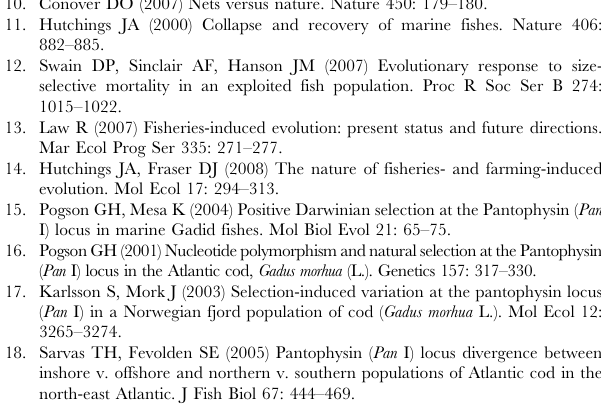
Figure S1 Generalized additive model smooth fit of frequency of A allele on depth of sampling. Shaded region represents two standard errors above and below fit; points are partial residuals; the gam smooth was fitted using a quasibinomial link function to model overdispersion; estimated degrees of freedom edf =3.2; approximate significance of smooth term F= 47.95 , P % 0.001 with 51.4% of deviance explained. Found at: doi:10.1371/journal.pone.0005529.s001 (1.17 MB TIF) Figure S2 Sampling stations for Atlantic cod on a map of Iceland. Icelandic Marine Research Institute spring spawning surveys conducted in 2005, 2006, and 2007. Color coded divisions are based on revised METACOD definitions [19,61]. No samples were taken from division 6 (not shown on map). Figure S3 Sampling stations for Atlantic cod condi- tioned on 25 m depth classes on a map of Iceland. Icelandic Marine Research Institute spring spawning surveys in 2005, 2006, and 2007. Color coded divisions as in Supporting Figure S2. Figure S4 Conditional densityplot of catch of Atlantic cod at Iceland on age by year class. Landings in numbers (millions). Age based on length at age relationships. Based on data from Table 3.1.6 in [27]. Figure S5 Density plot of catch on depth (m) by year for different gear. Data are from log book records. Figure S6 Total and proportional catch by gear in different years. Total catch in tons and proportion of total by gear. Catch data for 1992–2007 are official statistics from Statistics Iceland http://www.statice.is. Data for 2008 are provisional data from Directorate of Fisheries http://www.fiskistofa.is/en. Found at: doi:10.1371/journal.pone.0005529.s006 (0.89 MB TIF)